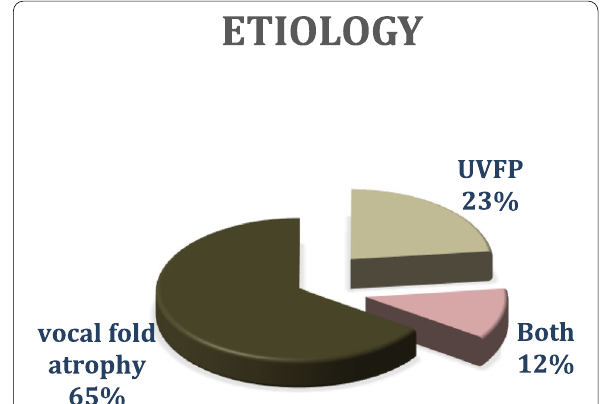
Fig. 1 Etiologies of glottal